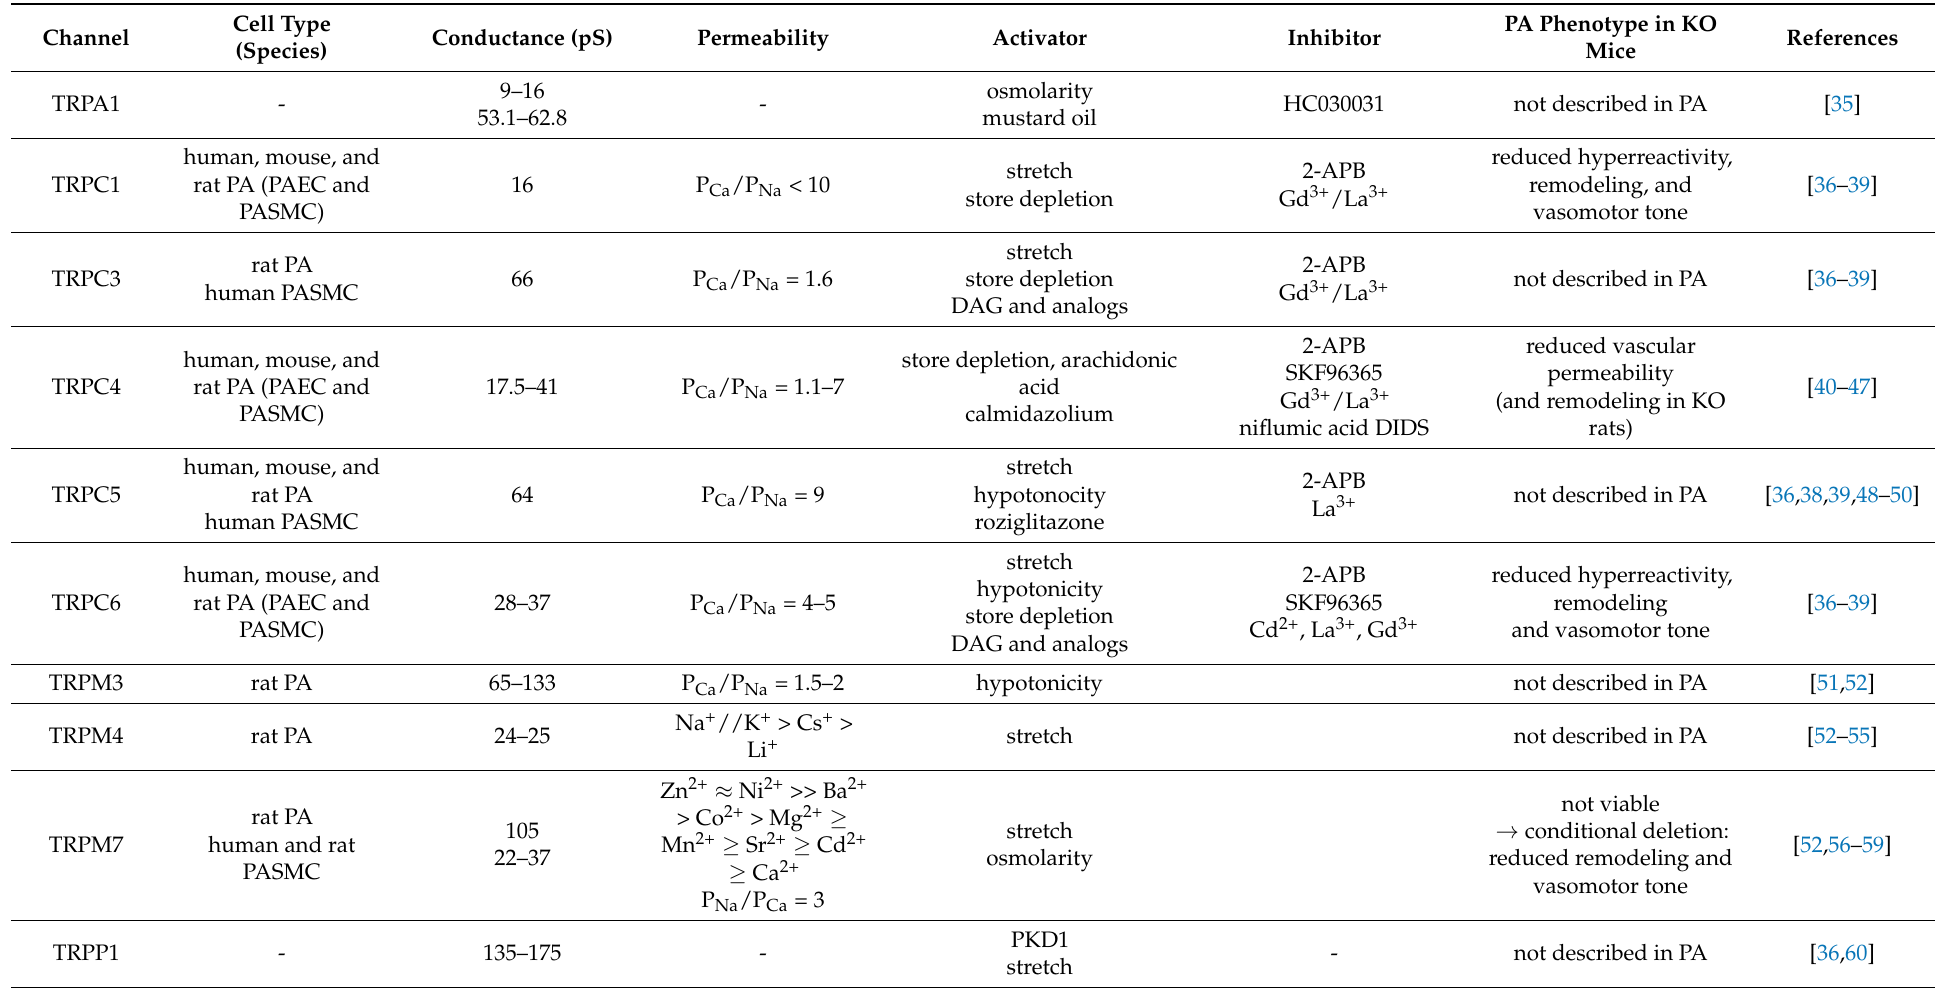
Table 1. Biophysical properties of TRP channels in pulmonary arterial vascular